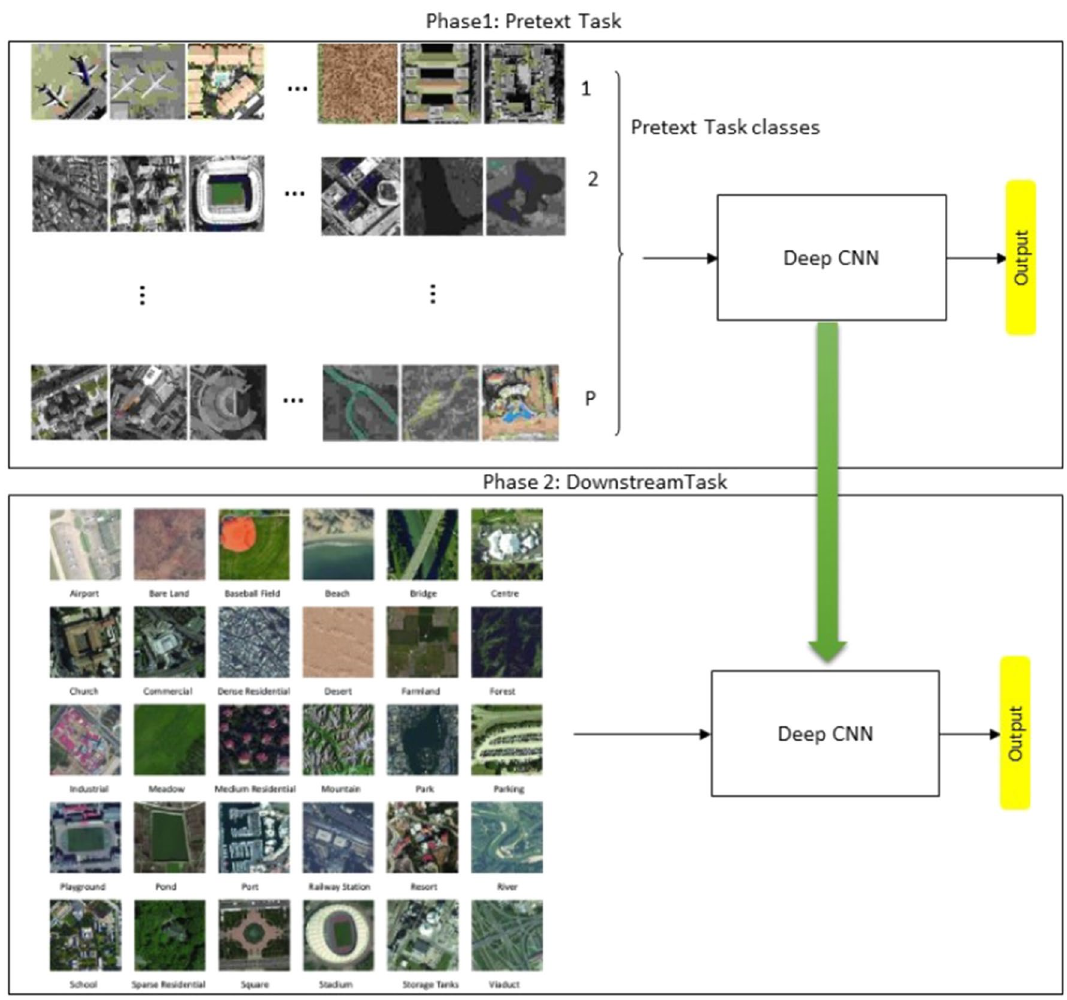
Figure 1. Illustration of the SSL framework, which consists of two phases of training. In phase 1, the model is pre-trained on the pretext task which uses pseudo labels assigned to the images. In phase 2, the model is fine- tuned on the downstream task using the labeled